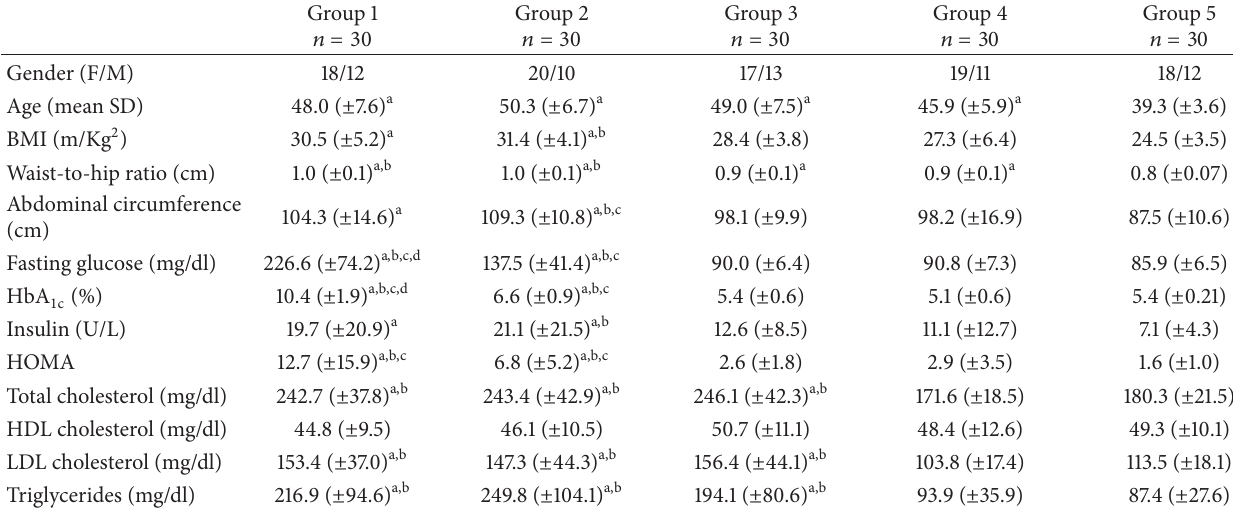
Table 2: Characteristics of the sample: demographic, physical, biochemical, and diabetic data (mean ±